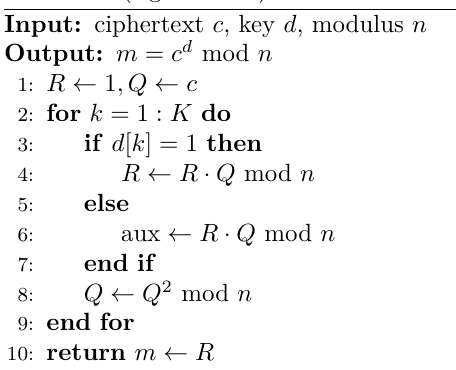
Algorithm 6 Multiply and square expo- nentiation